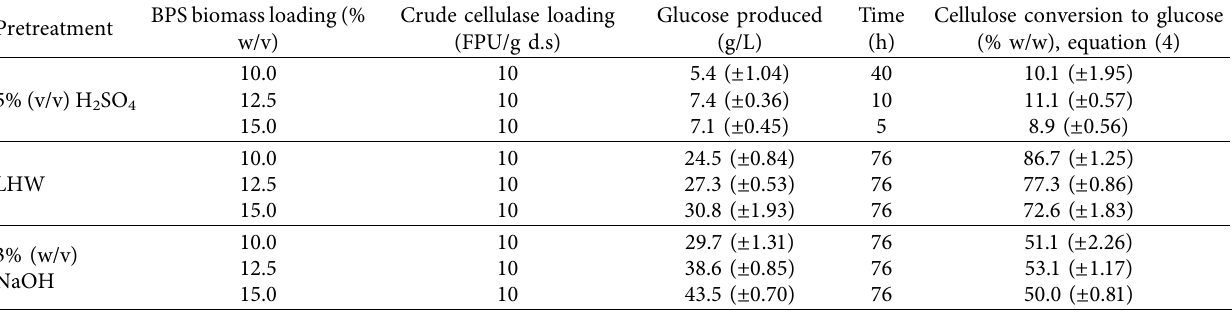
Standard deviation ± values of three independent repeats.